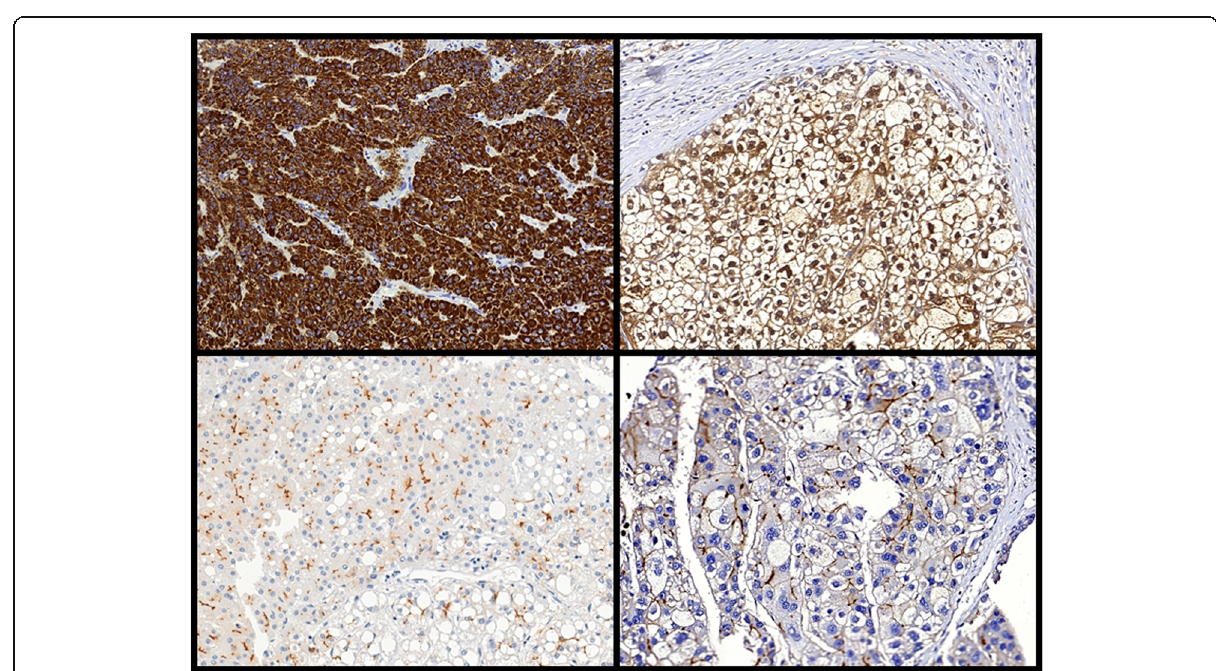
Fig. 4 IHC markers in HCC: HepPar1 (top-left), Arginase-1 (top-right), CD10 (bottom-left) and CEAp